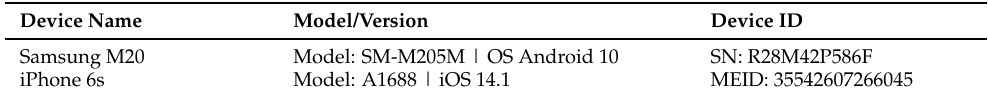
Table 3. Full specifications of the devices used in the